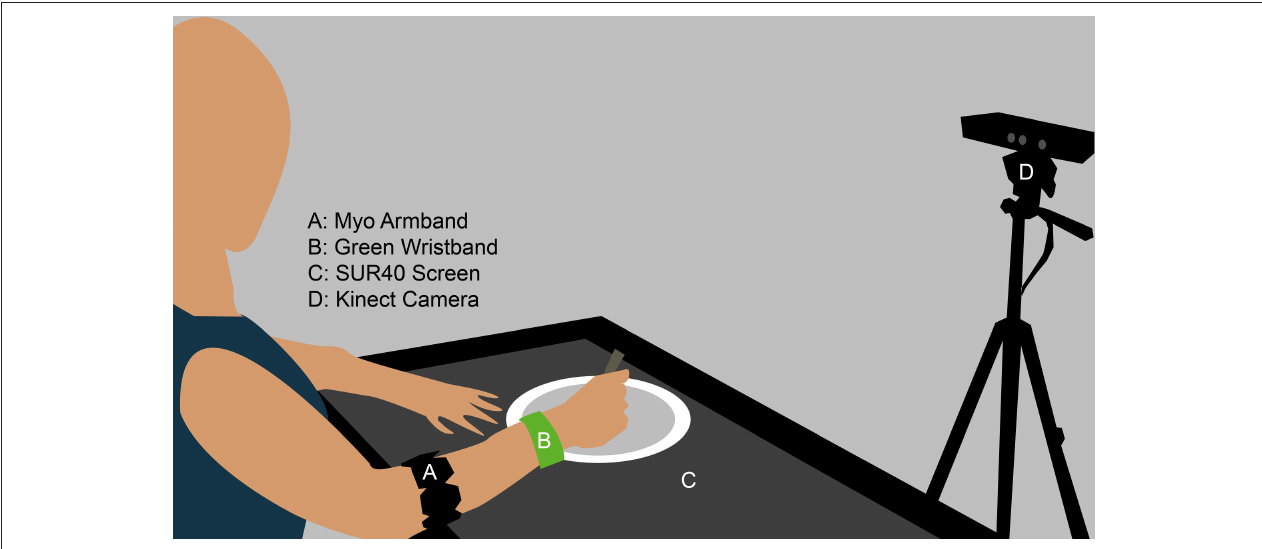
FIGURE 2 | Mockup of the experimental setup, shown with only one plate. The distance of the Kinect to the subject varied across our tests. To perform skeleton tracking, it must be placed further from the subject. Otherwise, when used for manual verification purposes or to monitor the position of the green wristband, it can be placed closer to the subject to capture more